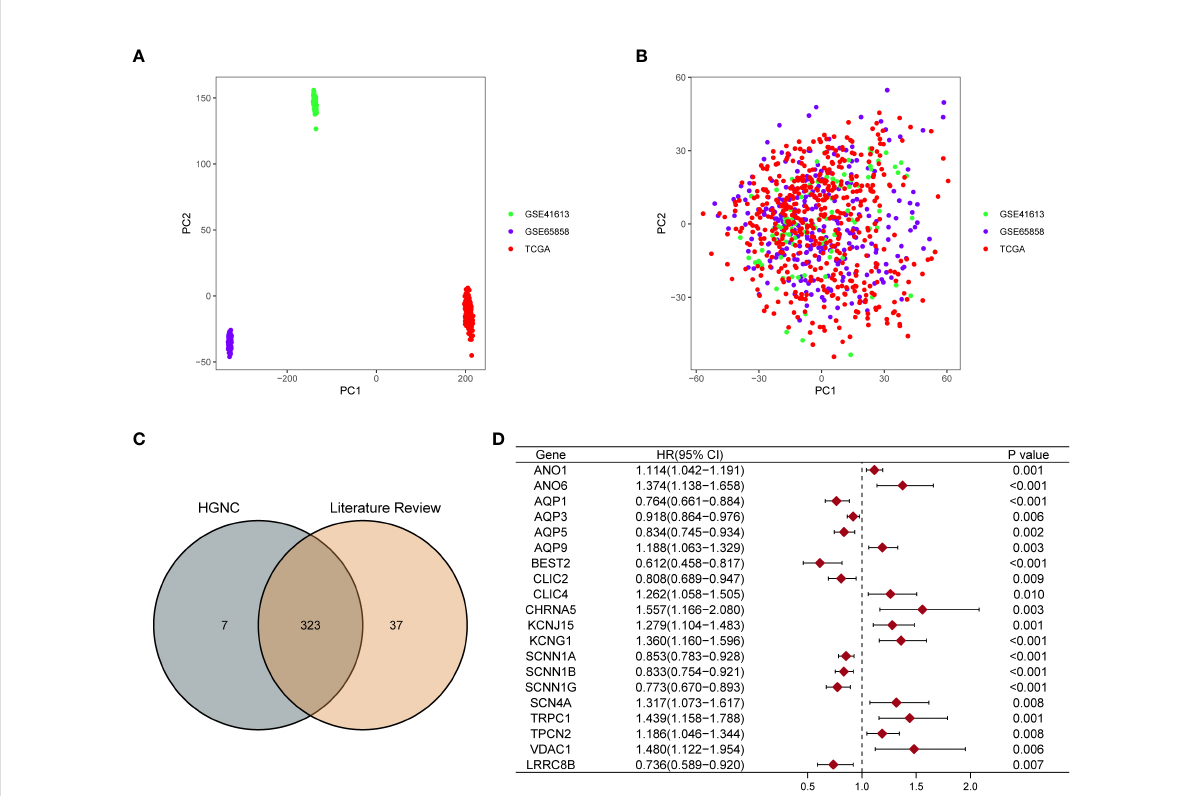
FIGURE 2 Screening ion channel genes related to the prognosis of HNSCC. PCA showed the distribution of three datasets before (A) and after removing the batch effect (B) . (C) Venn diagram showed that 323 ion channel genes were obtained by crossing the two gene sets. (D) The forest map showed that 20 ion channel genes related to the prognosis of HNSCC were identi fi ed by univariate Cox regression